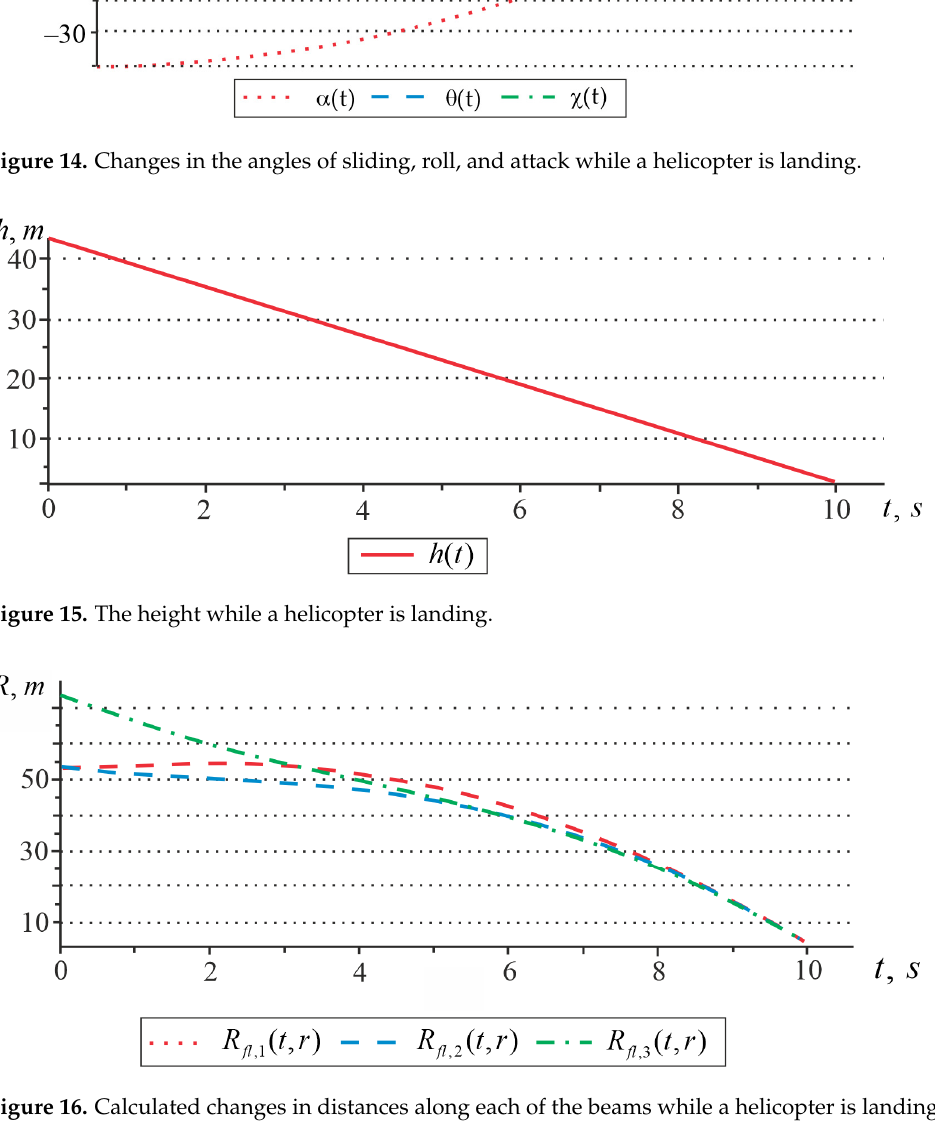
Figure 17. Estimates of the velocity vector components while a helicopter is